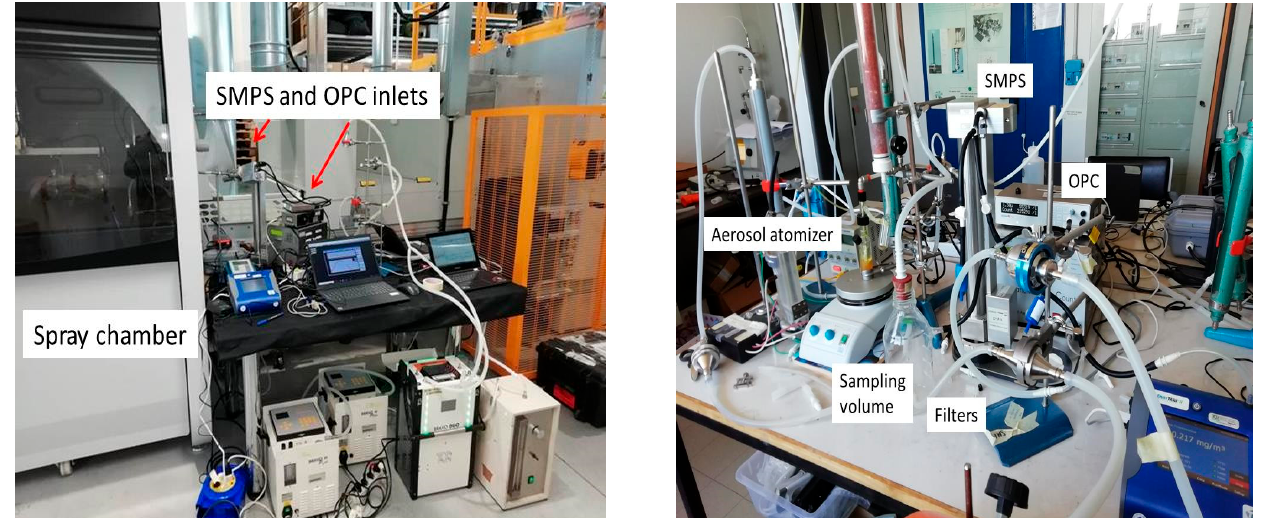
Figure 2. Experimental field campaign setup. On the left the setup used at field campaigns; while on the right at the laboratory.